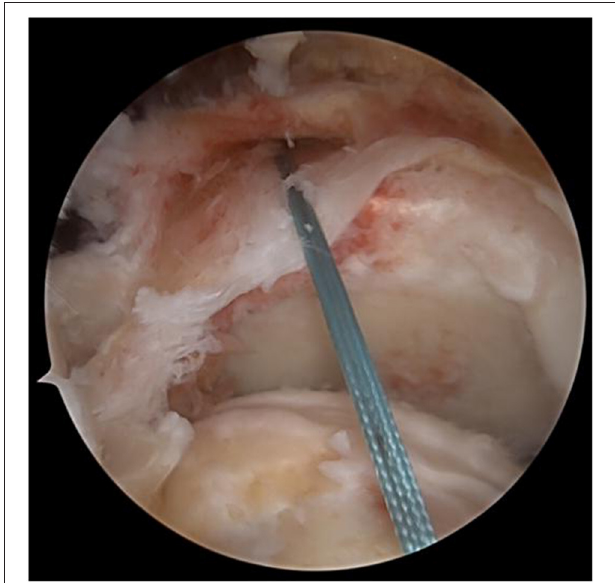
FIGURE 2 | The infraspinatus tendon could not be pulled back into the footprint area.